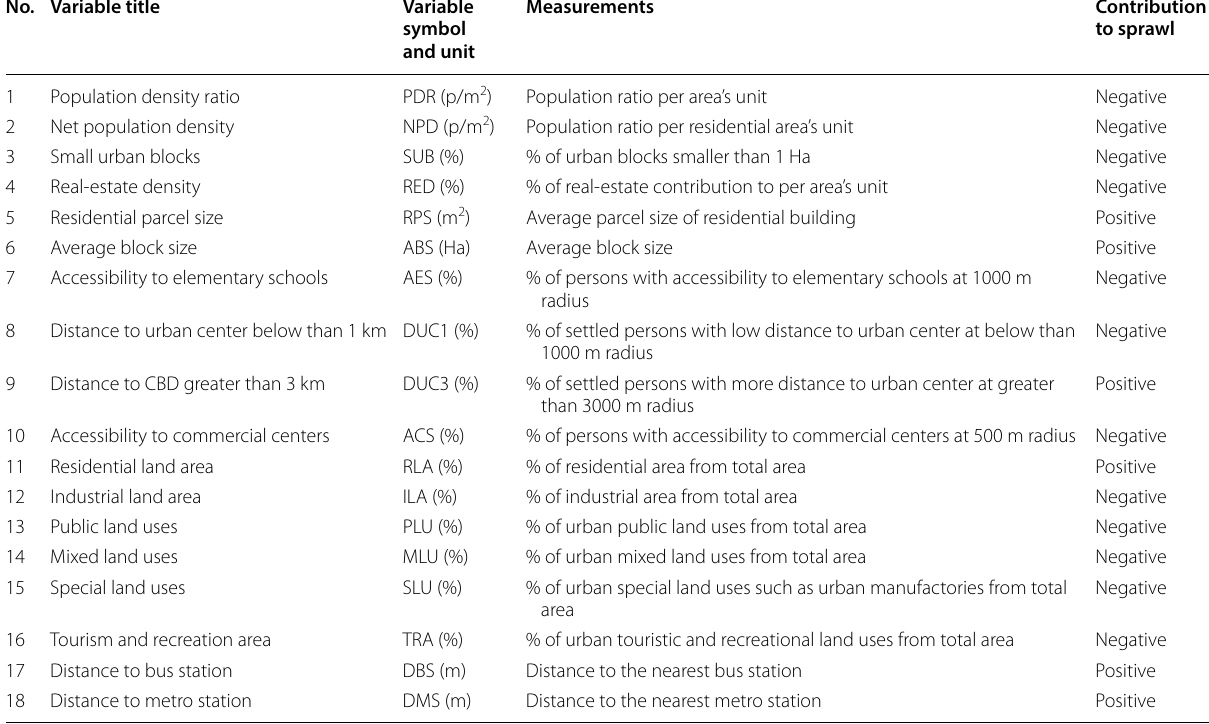
Table 1 The effective variables for urban sprawl and their contribution to sprawl